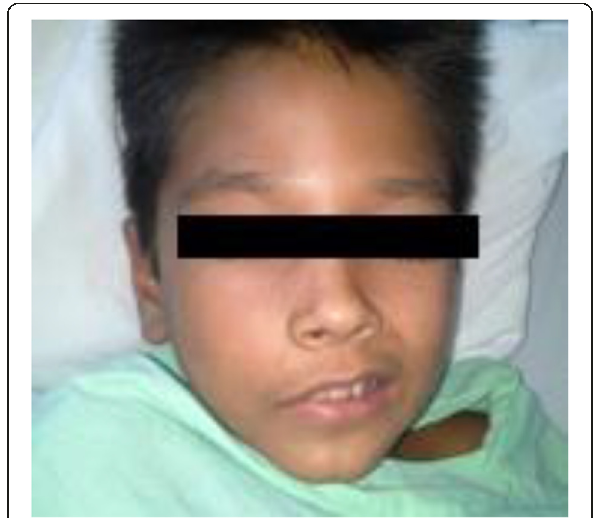
Fig. 3 Labial commissure deviation to the left side